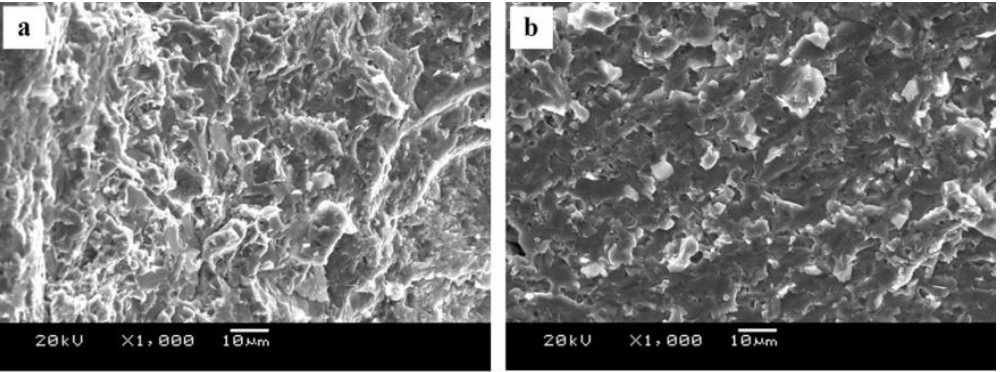
Figure 9. Fracture surfaces of joints with different Al content in the filler metal: ( a ) Zn–10Al; ( b ) Zn–20Al; ( c ) Zn–30Al and ( d )